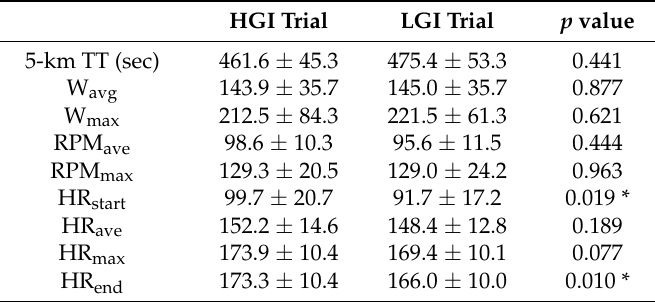
Table 2. Performance parameters in the 5-km TT